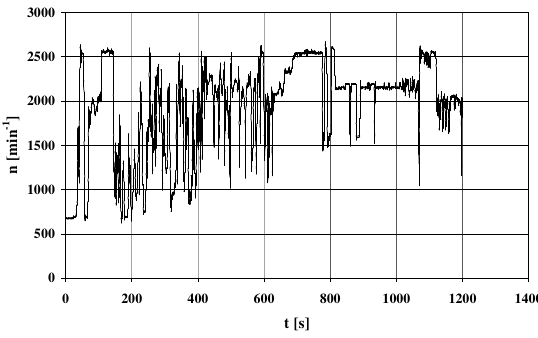
Fig. 5. Engine speed – n vs. time – t curve, recorded during the BRDT test